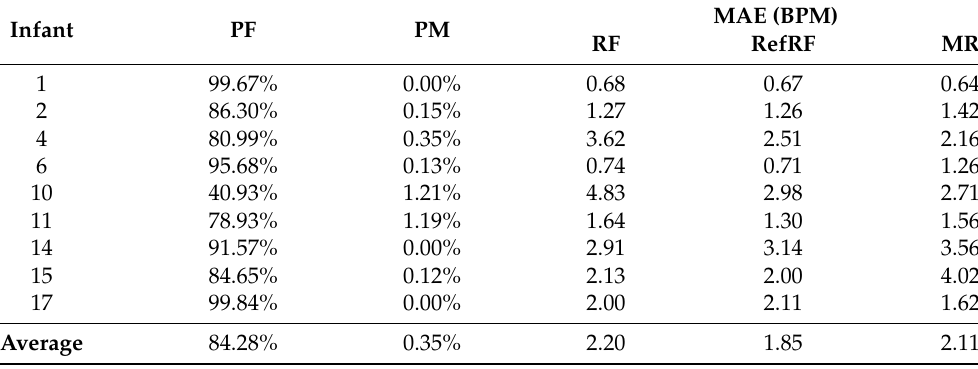
Table 2. Percentage of correct RF pixel detection, PF , and RM pixels erroneously included, PM . MAE comparing the RRs of the CI with the RRs of the RF signal , the RefRF signal , and the MR signal .